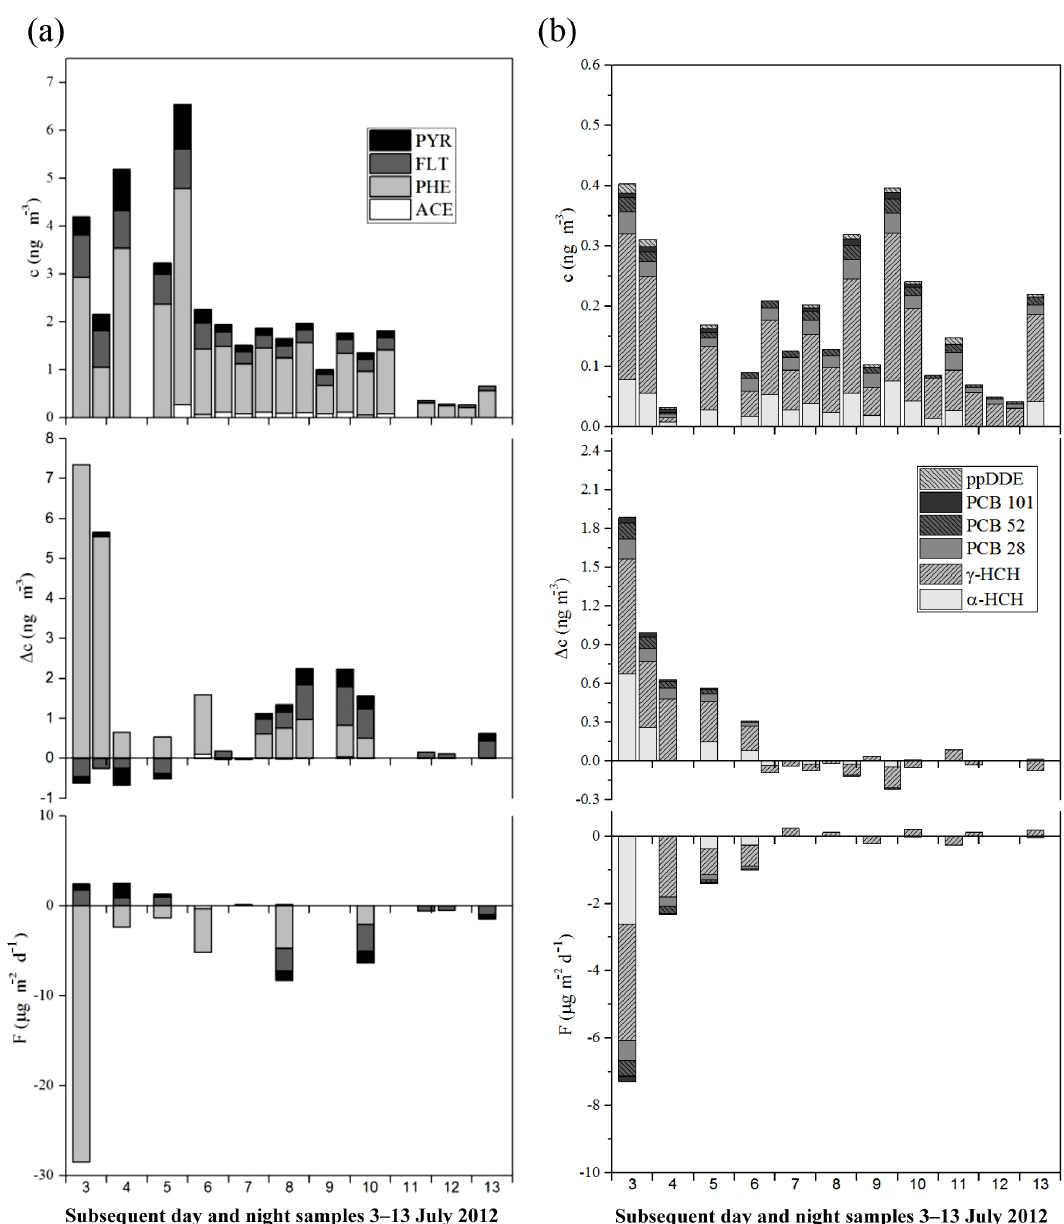
Figure 1. Gaseous (a) PAH and (b) halogenated substances’ concentrations at ground level, z 1 = 1 . 05m (upper), vertical concentration differences, (cid:49)c z = c z 2 − c z 1 , over (cid:49)z = 1 . 75m (middle) and vertical fluxes, F c = − v tr (cid:49)c z (positive indicates upward, negative indicates downward; lower). Only significant data (exceeding uncertainty thresholds) are shown; gaps represent no